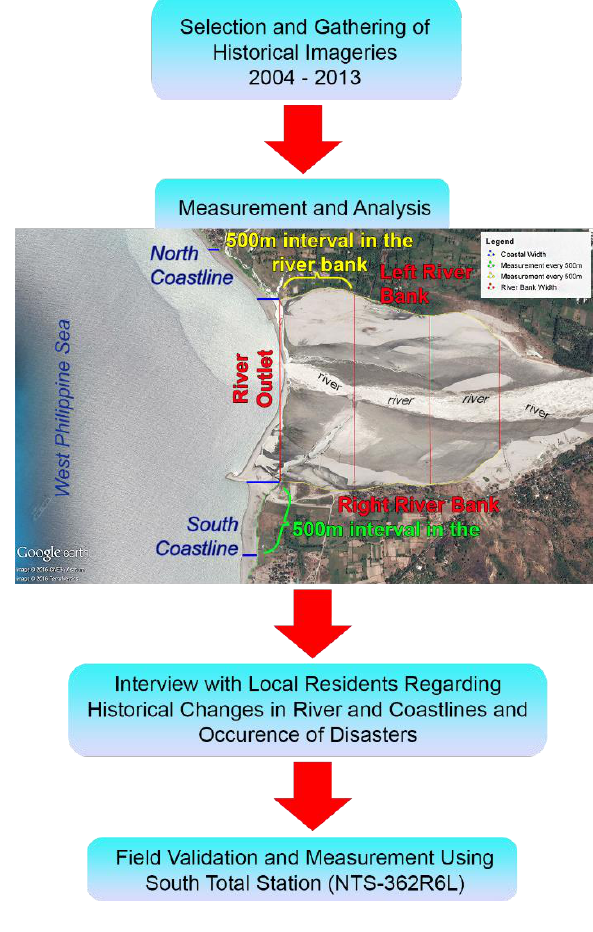
Figure 1. Process flow of the